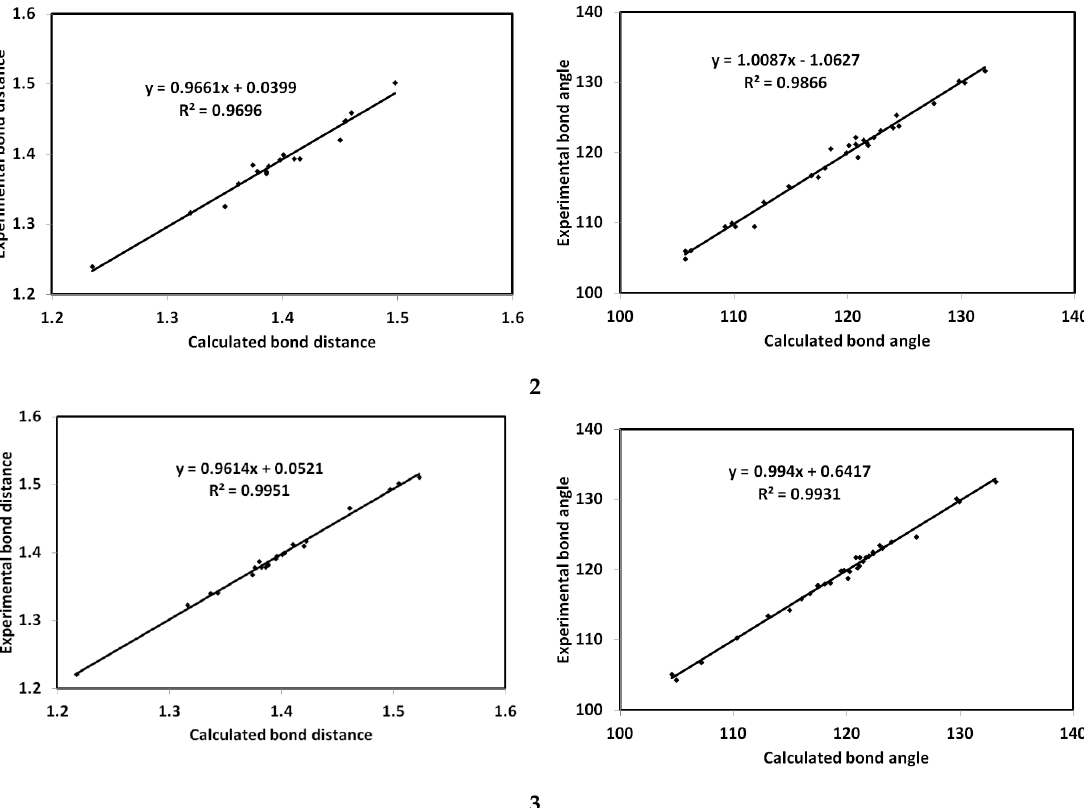
Figure 7. Correlation graphs (experimental and calculated) of N -methyl - β -enaminones (bond distance and angles).